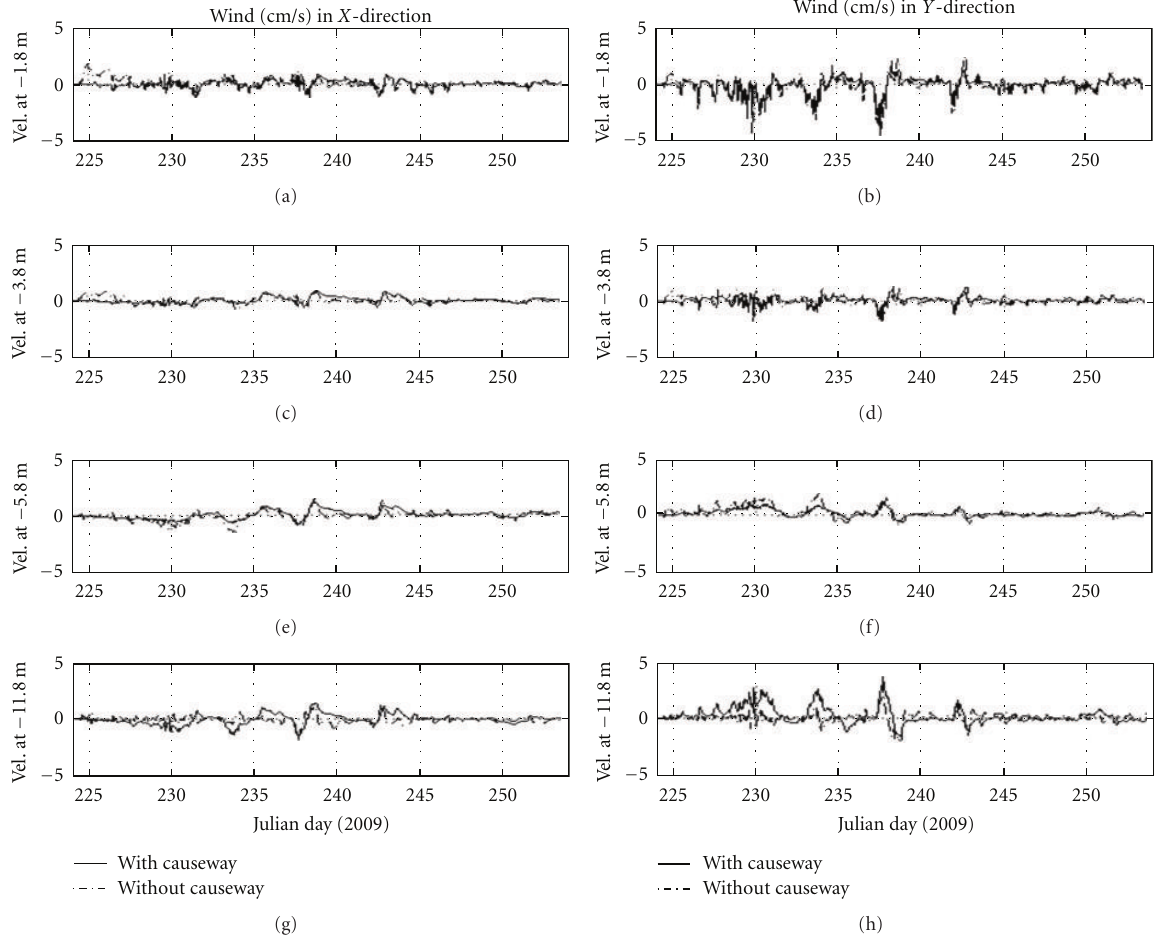
Figure 12: The comparisons of the simulated flows in the di ff erent depths at the WTP intake location with and without the causeway included in the simulations.